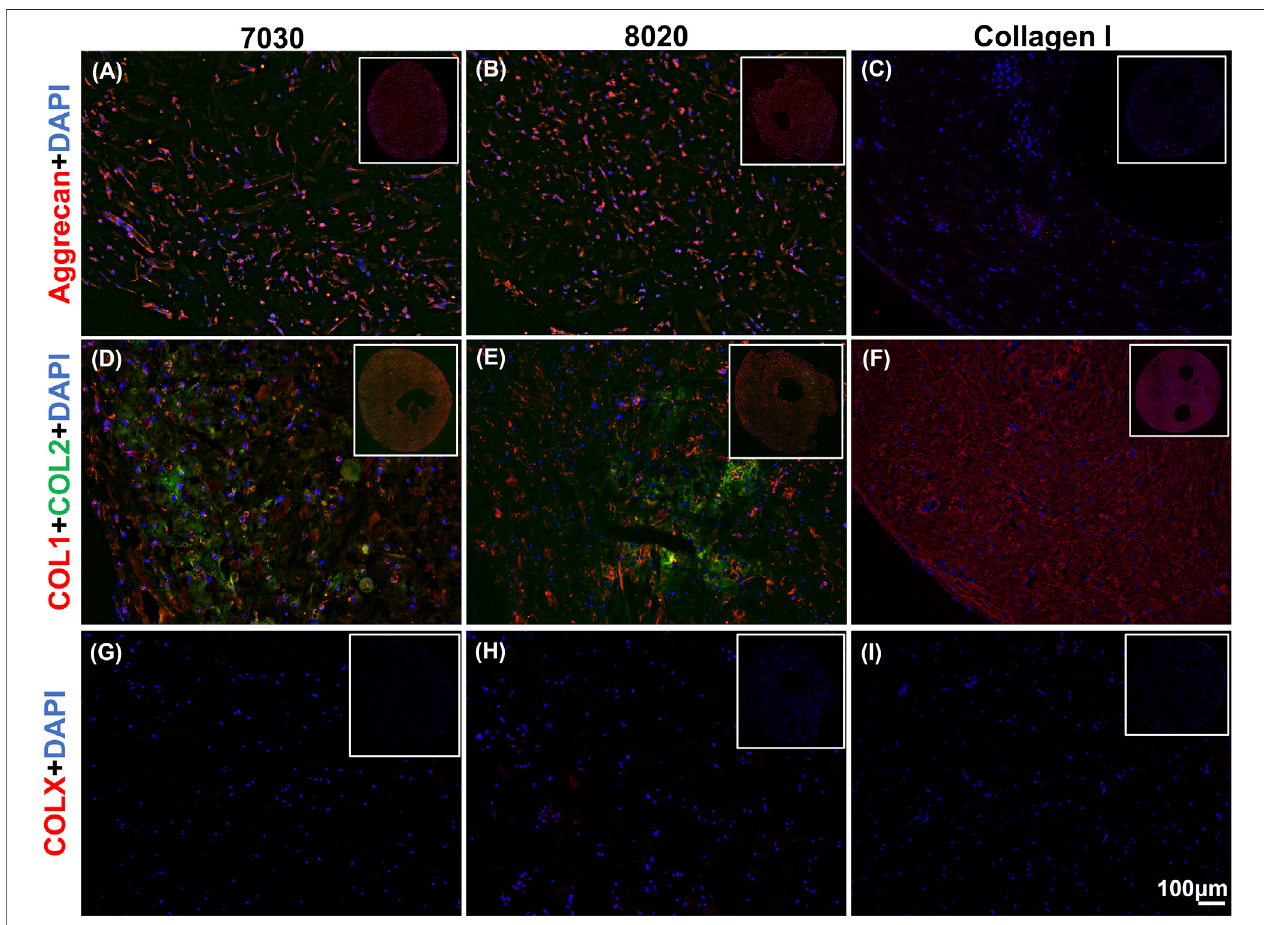
FIGURE6| Immuno fl uorescentstainingof (A – C) ofaggrecan(red), (D – F) collagensIandII(redandgreen,respectively),and (G – I) collagenX.Thestainingofnuclei is blue. Scale bar is 100 μ m.